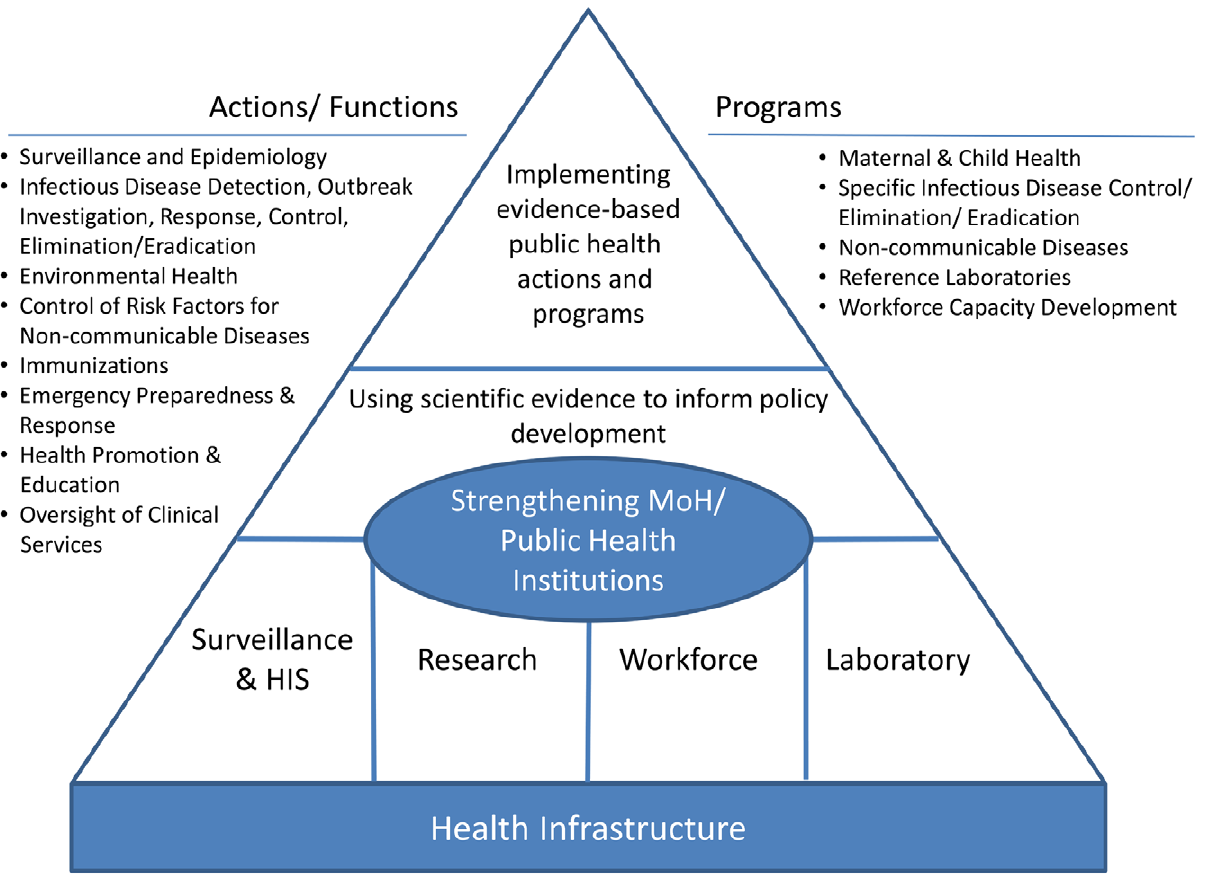
Figure 1. Public health framework for health systems strengthening.